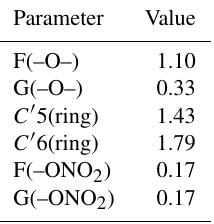
Table 4. SAR results: new calculated neighboring effects parame- ters for ethers, cyclic ethers and organic nitrates (using case 3 con-